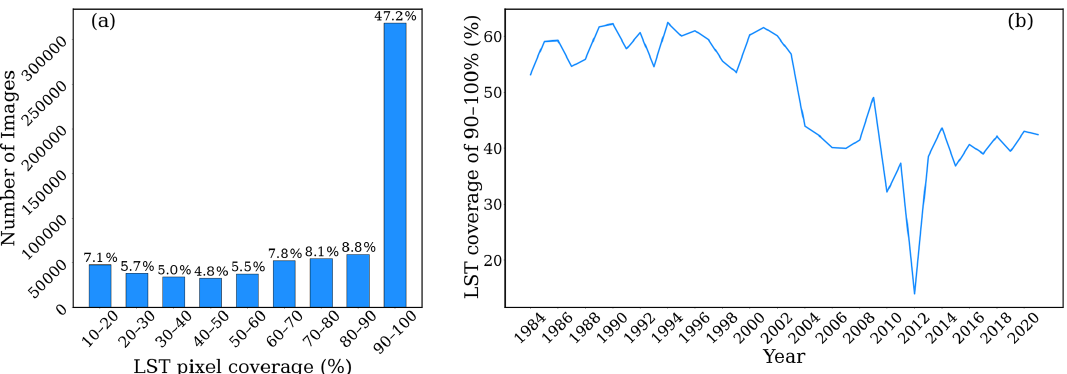
Figure 4. (a) Distribution of LST pixel coverage (%) and (b) yearly percentage of the dataset, with LST coverage ranging from